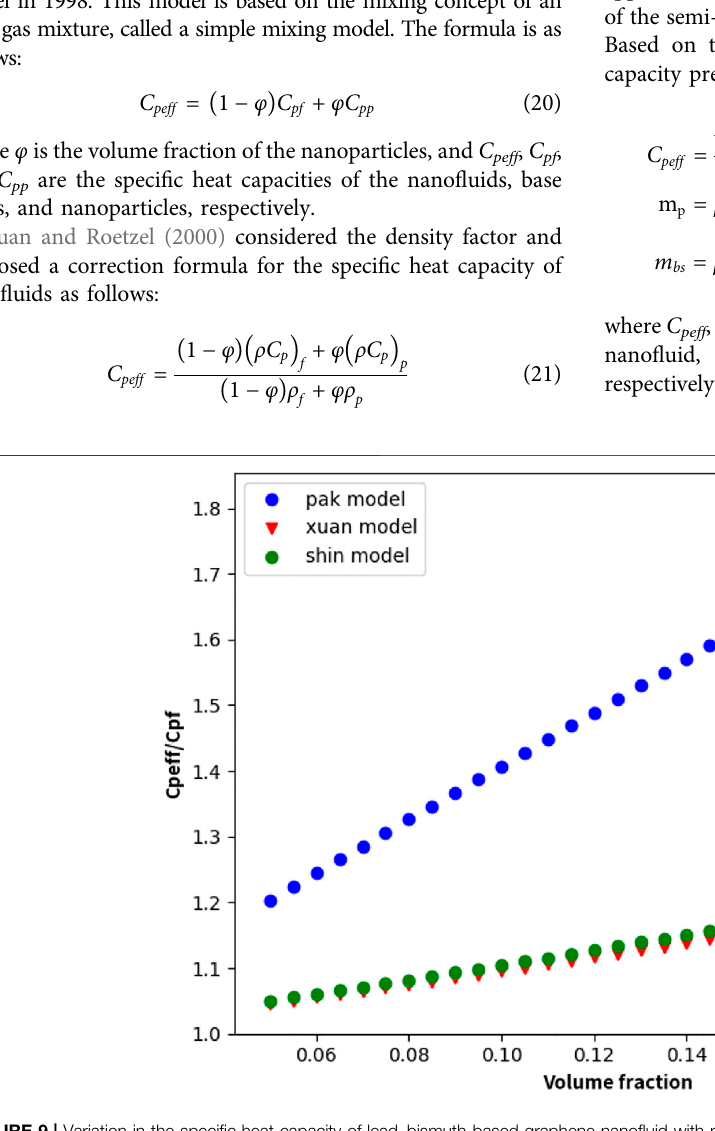
Frontiers in Energy Research |